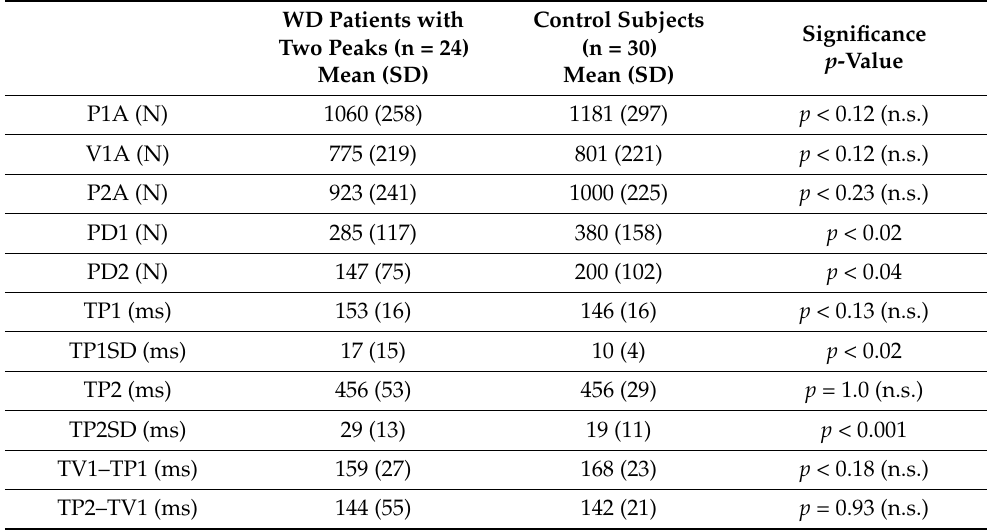
Table 2. Comparison of amplitudes and temporal parameters of the GRF-curves in 24 WD patients and 30